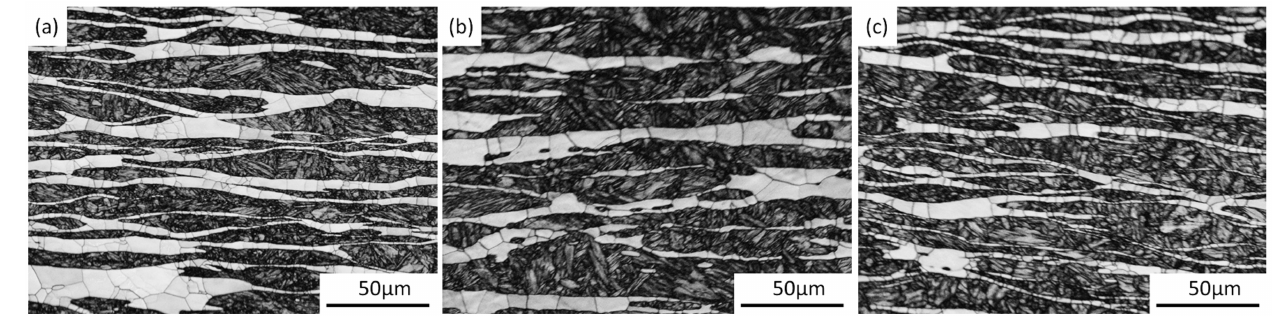
Figure 13. EBSD band contrast maps under the conditions of ( a ) 950 ◦ C, ( b ) 1050 ◦ C, and ( c ) 1150 ◦ C with a strain rate of 0.1 s − 1 .